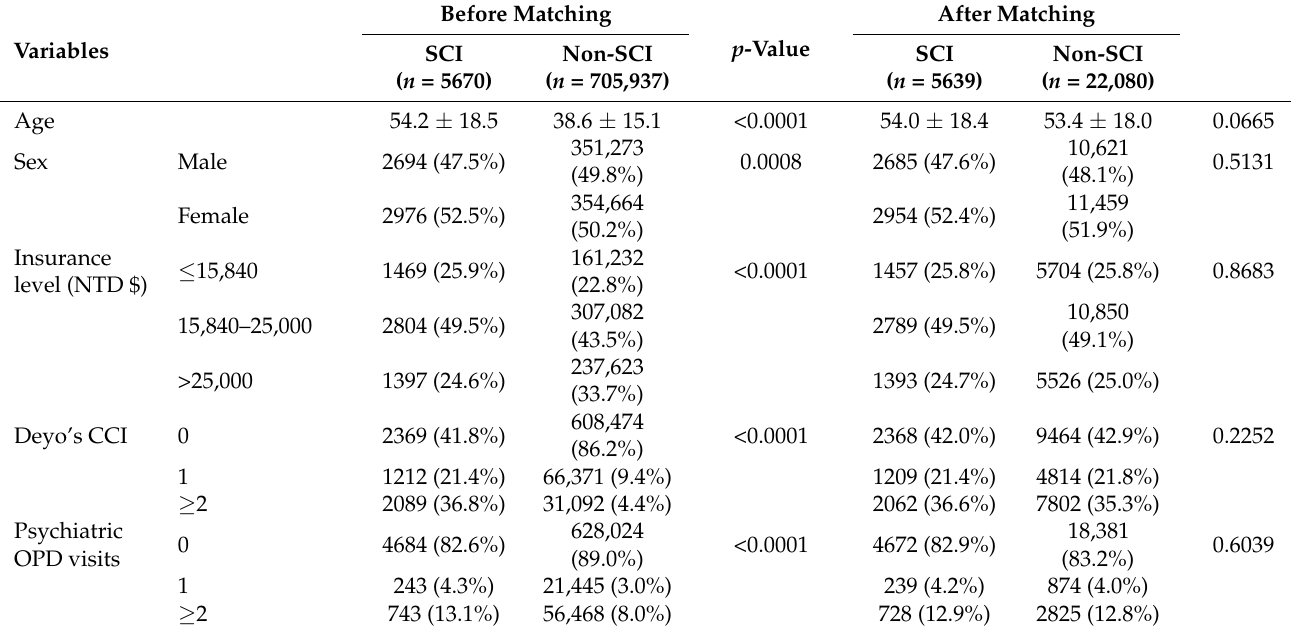
Table 1. Baseline Characteristics of the Study